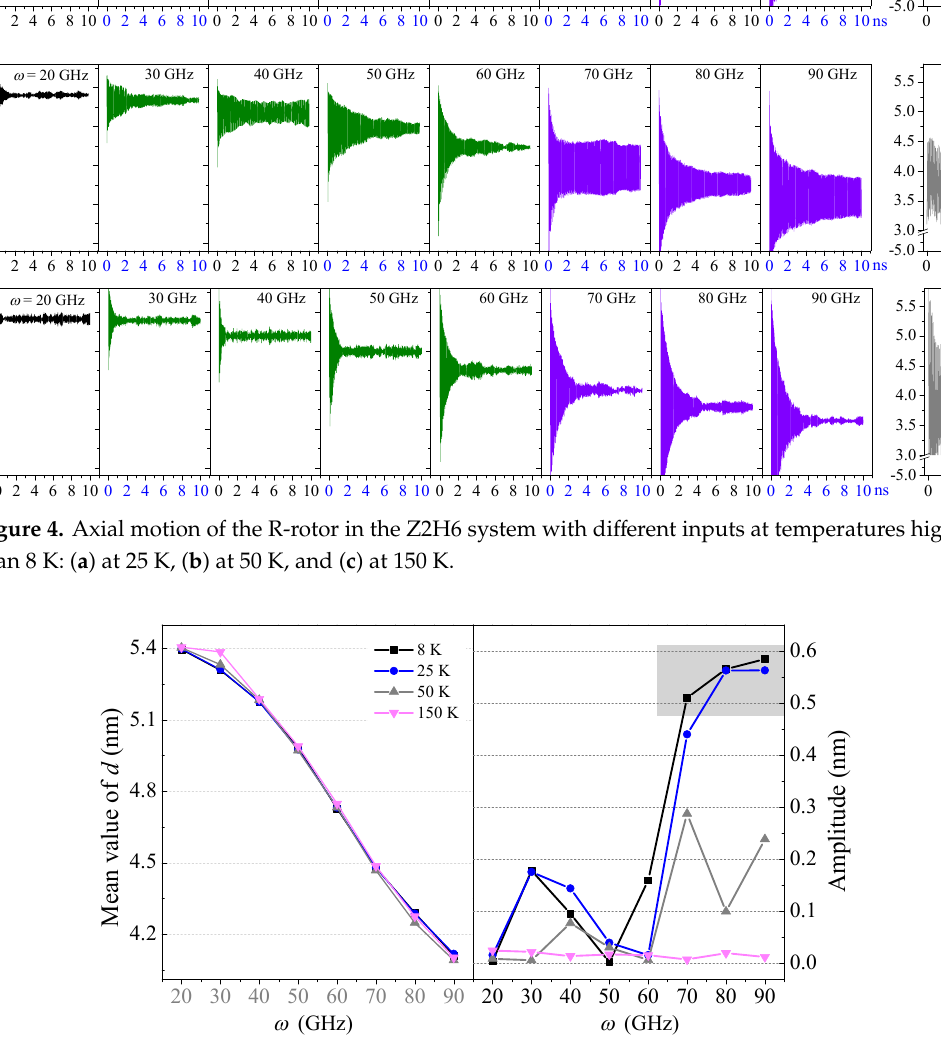
Figure 4. Axial motion of the R-rotor in the Z2H6 system with different inputs at temperatures higher than 8 K: ( a ) at 25 K, ( b ) at 50 K, and ( c ) at 150 K.